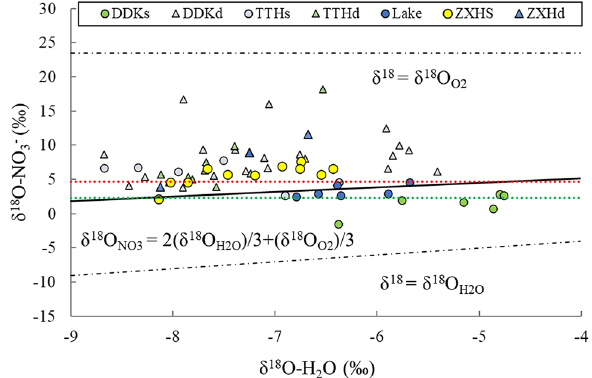
Figure 2. Variations in δ 18 O–H 2 O and δ 18 O–NO 3− values in Shengjin Lake basin. Note: The three lines represent the theory lines in different conditions. The red and green dashed lines indicate the maximum and minimum theoretical values of δ 18 O–NO 3− ,